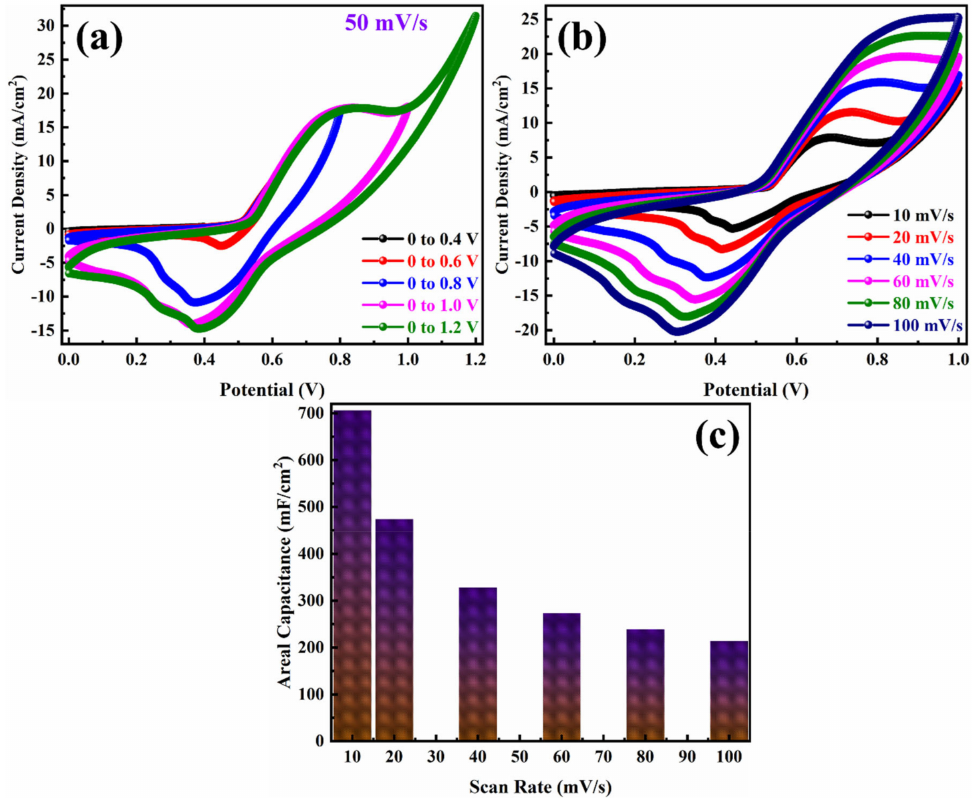
Figure 8. Cyclic voltammograms in ( a ) different potential windows at a scan rate of 50 mV/s and ( b ) in the optimum potential window from 0 to 1 V at different scan rates, and ( c ) the corresponding areal capacitances obtained from the cyclic voltammograms of PANI/NF//JAC/NF